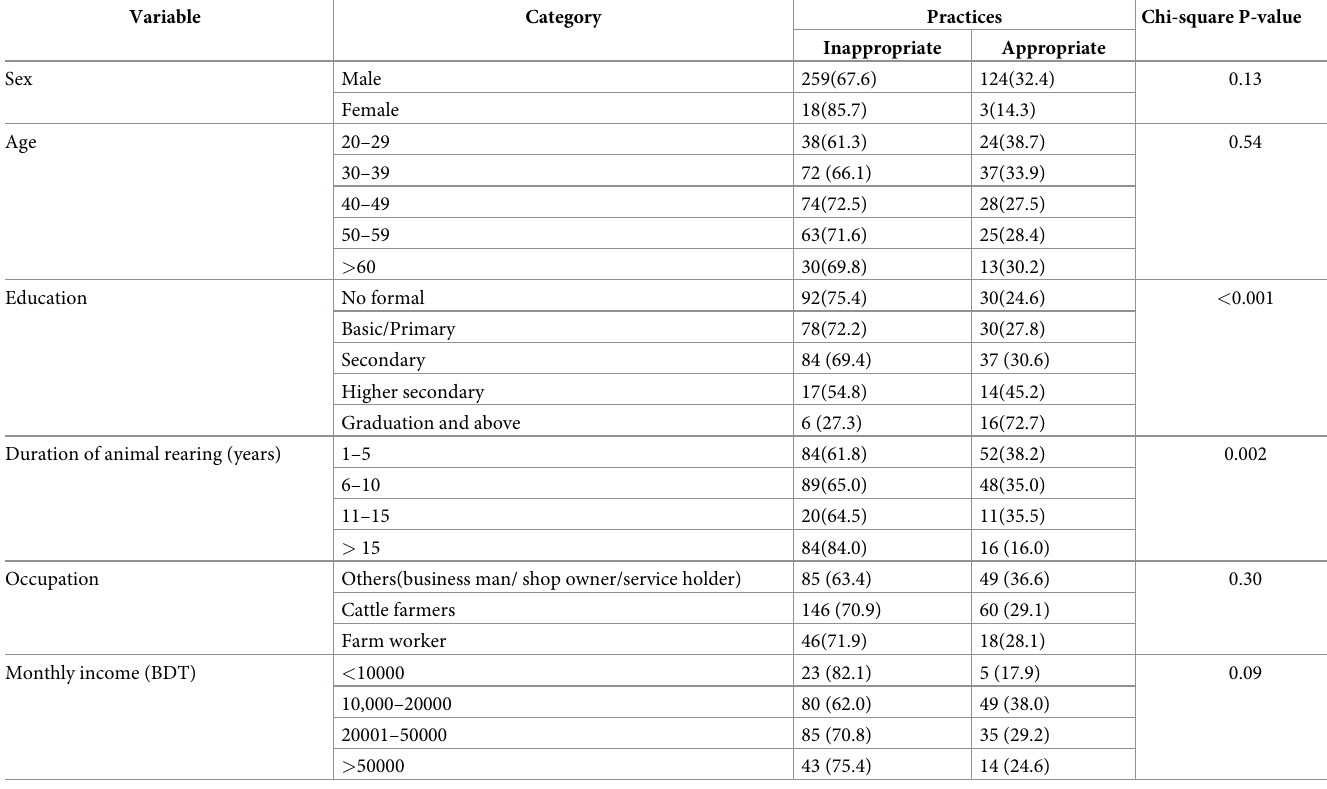
The Hosmer and Lemeshow goodness of fit test (P-value of 0.28 and 0.69, respectively, for knowledge and practices models) indicated adequate model fit. The accuracy of the final Table 6. Association between zoonotic tuberculosis practices with cattle handlers’ demographic and socioeconomic characteristics in the selected districts of Bangladesh.